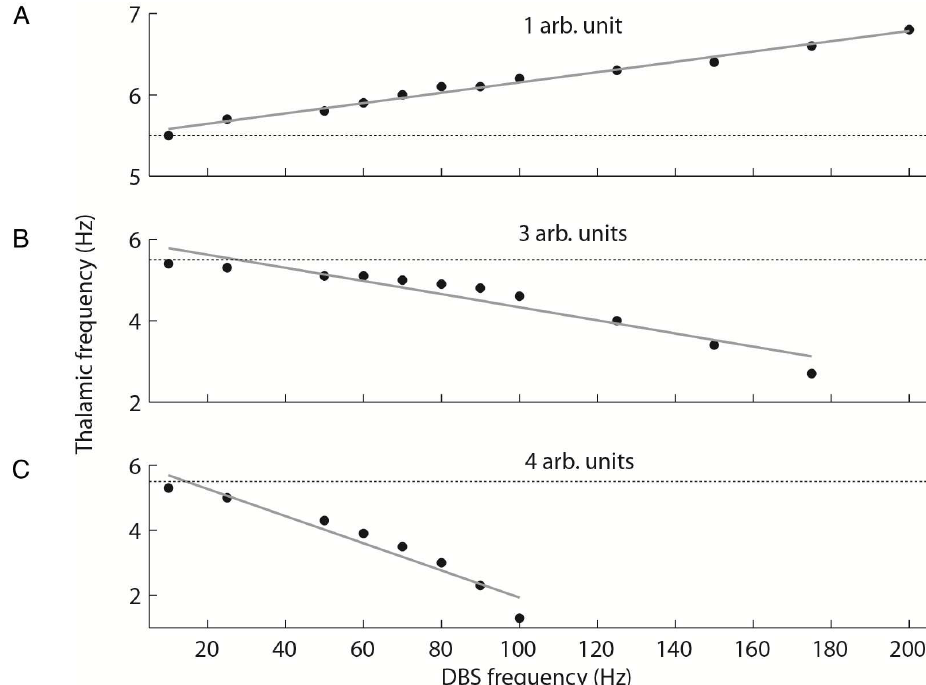
Fig 6. DBS effectson oscillatory activity. When the DBS input is appliedto the Vim, the effect on the oscillatory activity is both amplitudeand frequencydependent.(A) At low amplitudes, DBS changesthe frequency of the oscillation, and the relationshipbetweenthe appliedand the resulting frequencyis linear. (B) At higherDBS amplitudes, this relationship changes,and the higherthe DBS frequency the lower the frequency of the high amplitudeoscillation, which is eventually replaced by the low-amplitude, high frequency activity. When the DBS amplitudeincreasesfurther (C), this switch from low-frequency, high-amplitude activity to low-amplitude, high-frequency activity occurs at a lower stimulation